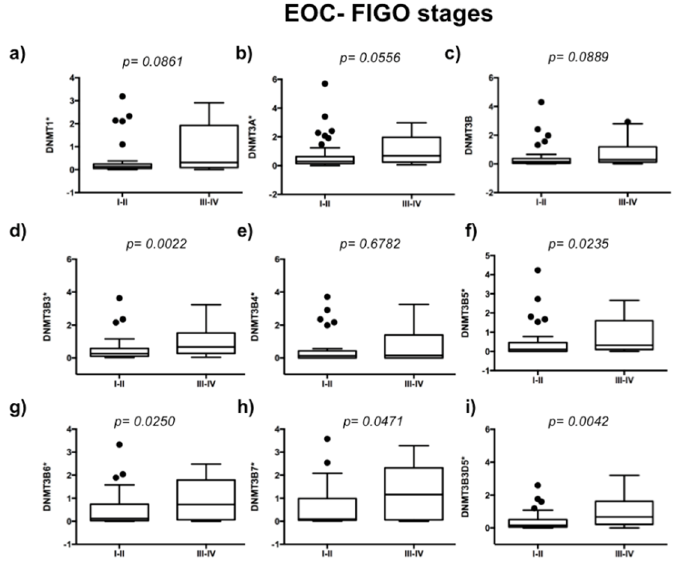
Figure 1. Overexpression of DNMT3B3, DNMT3B5, DNMT3B6, DNMT3B7, and DNMT3B3 Δ 5 according to the clinical stage of epithelial ovarian cancer (EOC). DNMT isoforms’ expression